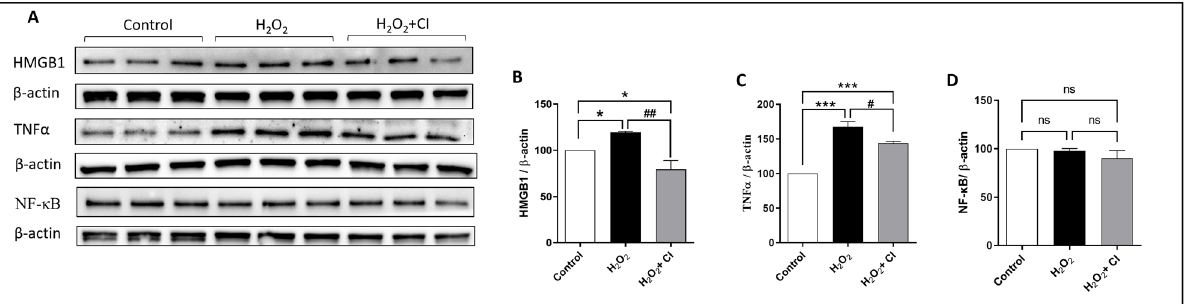
Figure 2. The effect of CI treatment on the H 2 O 2 -induced microglial cell activation. HMC3 microglial cells were treated with 200 µ M H 2 O 2 with or without 10 µ M CI for 24 h, and then, the protein expression level was evaluated by WB. ( A ) WB of different proteins in the microglial cell lysate 24 h following H 2 O 2 treatment. Analysis of WB shows that relative to H 2 O 2 stimulated control, treatment with CI reduced the H 2 O 2 -induced HMGB1 ( B ) and TNF α ( C ) expression significantly, while there was no significant change in the expression of NF- κ B ( D ). Data are expressed as mean ± SEM of three independent experiments, where p < 0.05 was considered significant. * p < 0.05, *** p < 0.001 relative to control group. # p < 0.05, ## p < 0.01 relative to H 2 O 2 group. (See Figure S2 for original Western blot images.)